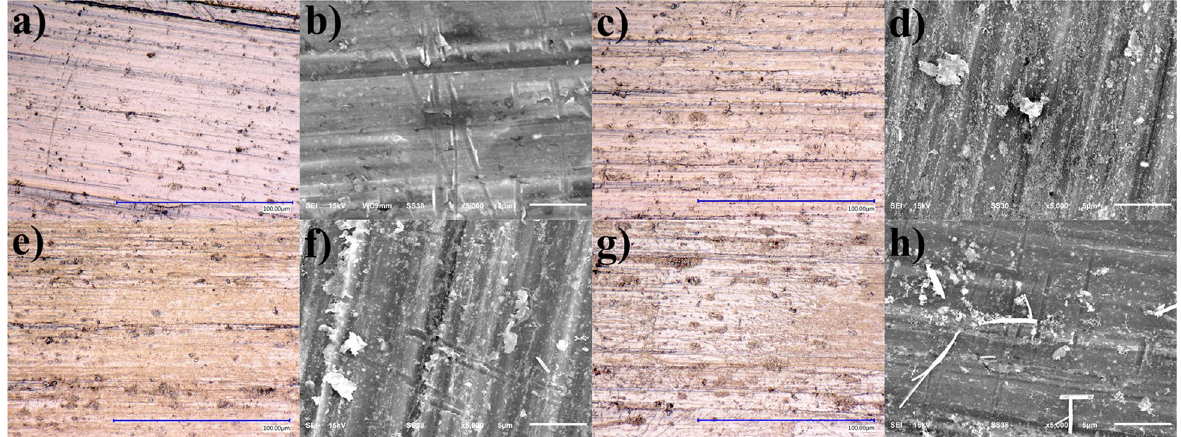
Figure 2. Optical micrographs at 2000× (scale bar 100 µm) and SEM images at 5000× (scale bar 5 µm) of samples immersed in Sm